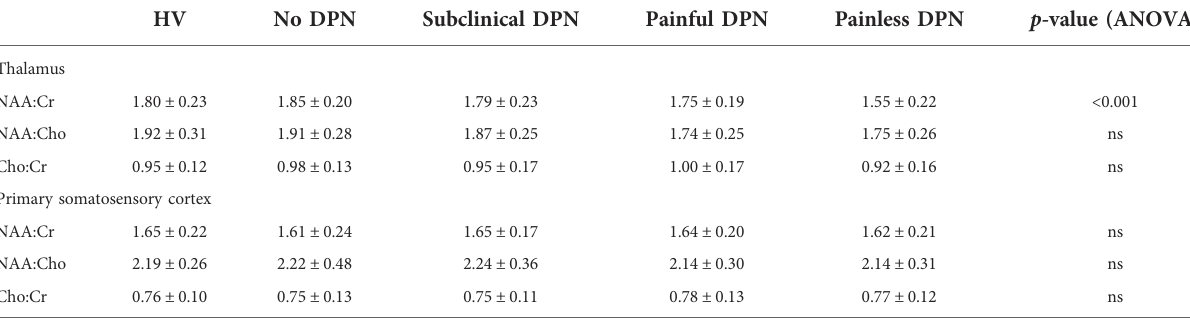
TABLE 2 Magnetic resonance spectroscopy measurements in the thalamus and primary somatosensory